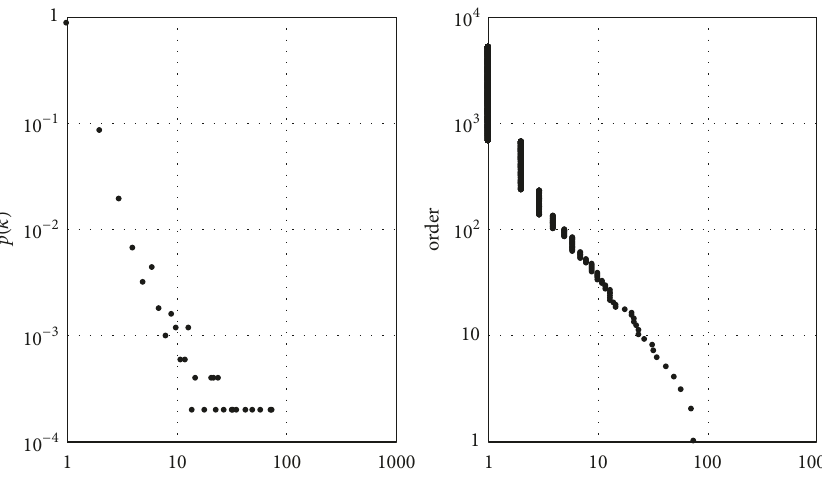
Figure 4: Distributions of the VLs in